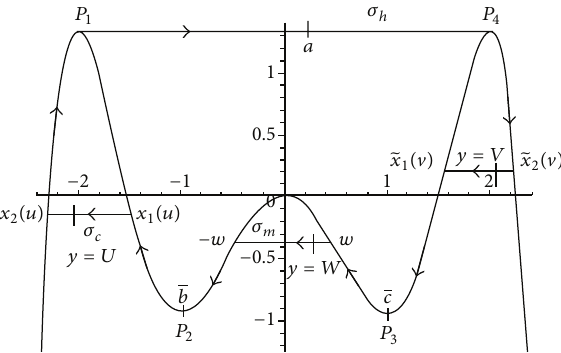
Figure 5: Canard cycles Γ 𝑈𝑉𝑊 of system